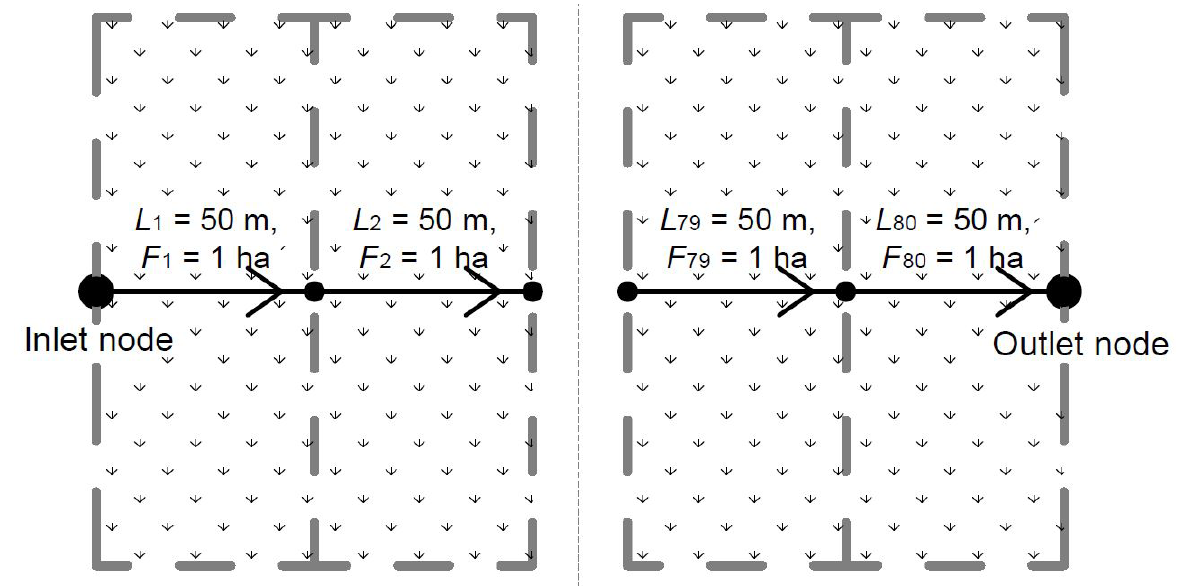
Figure 6: The scheme of the model catchment, total drainage area F = 80 ha (developed based on